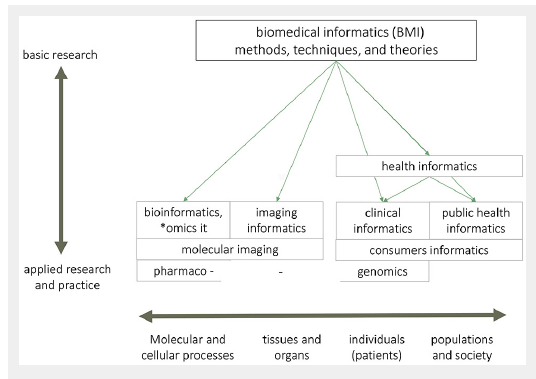
Biomedical informatics and its areas of application and practice. This figure, adapted from the International Medical Informatics Association publication on the definition of biomedical informatics [3], illustrates the umbrella relation between biomedical informatics and other related fields applying information sciences and technologies to